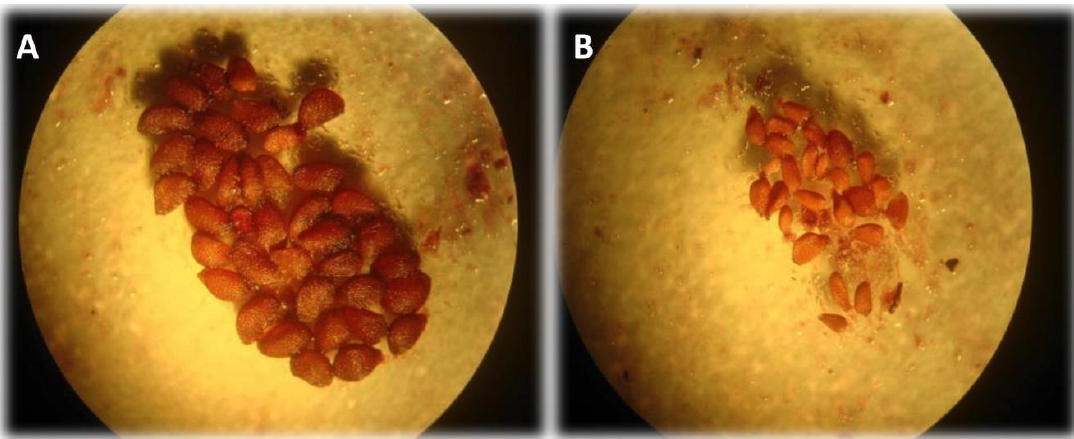
Figure 1. Wild blueberry seeds dissected from fruit under a stereo microscope (40X). ( A ) viable fully formed “plump” seed. ( B ) Shriveled and deformed aborted seeds. Aborted seeds are due to incompatible pollen, often self-pollen.